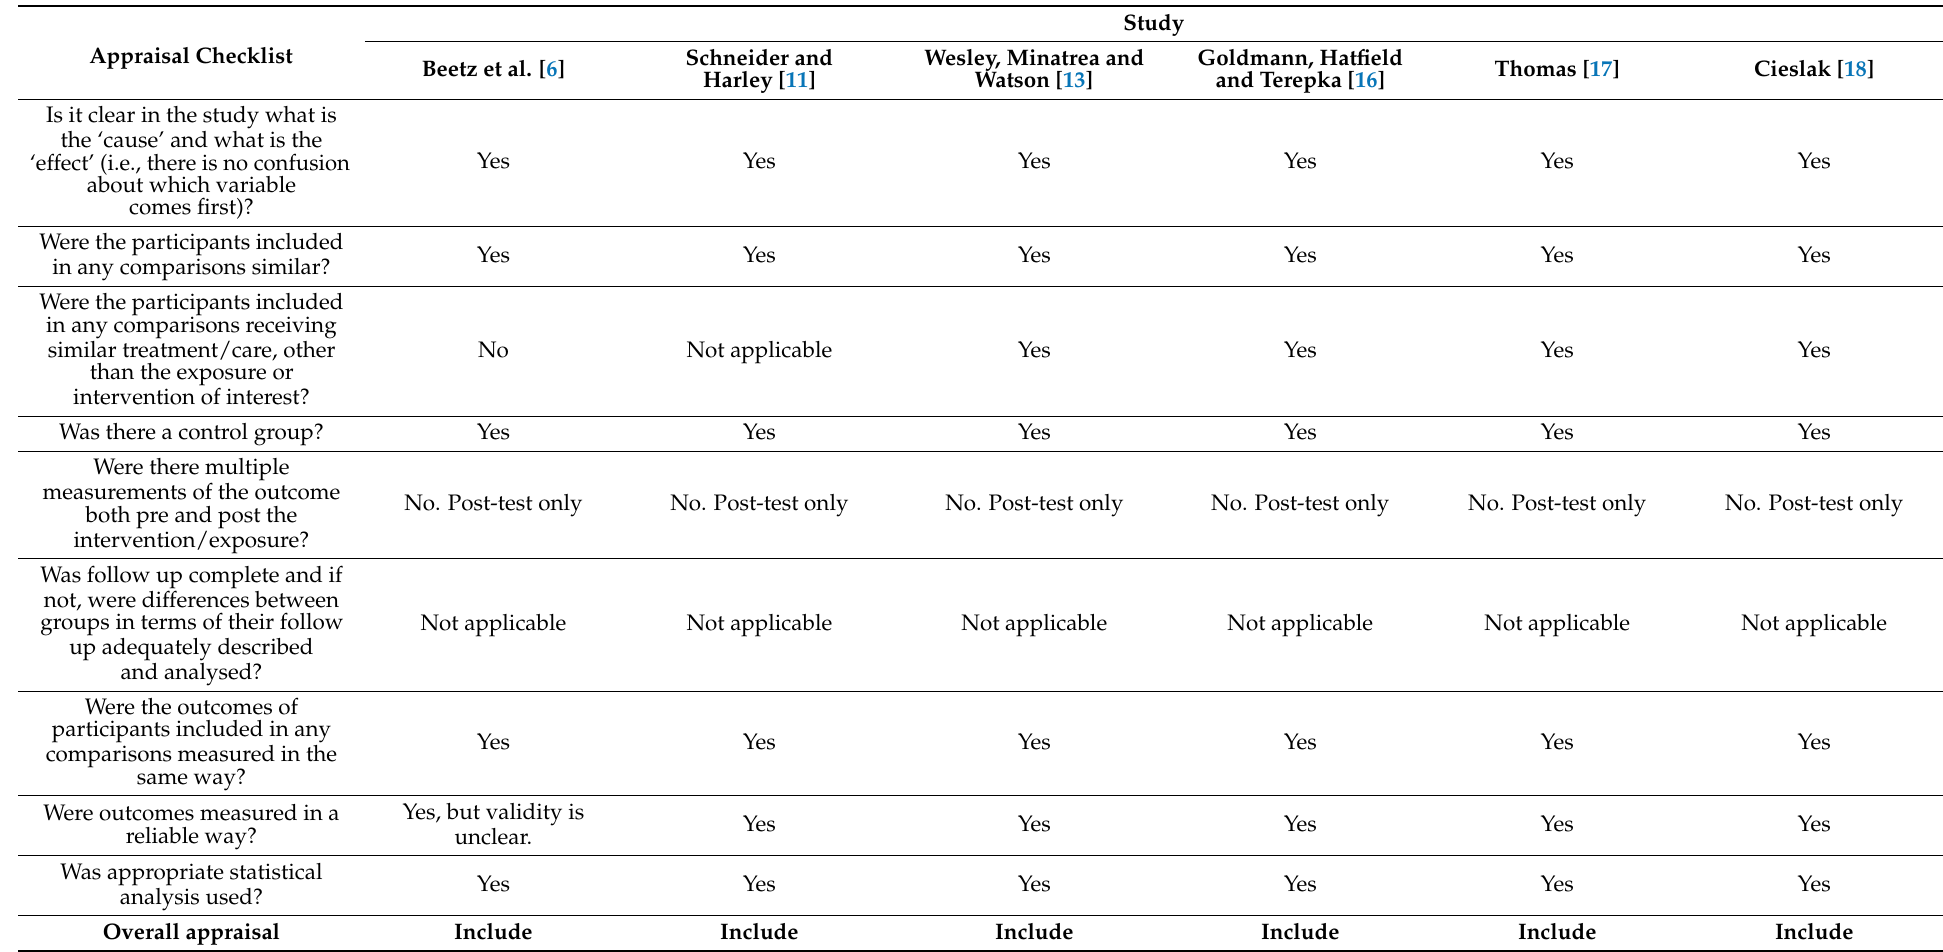
Table 2. Summary of quality and risk of bias for the included